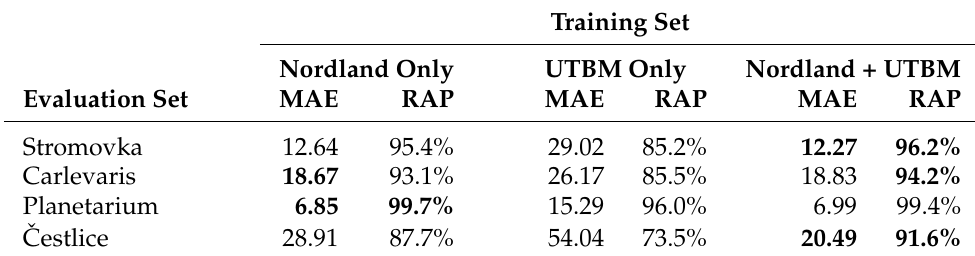
Table 3. Results when trained on different datasets, with both mean average error (MAE) in pixels and ratio of accurate predictions (RAP) calculated as described in Section 4.4. The threshold for ratio of accurate prediction (RAP) was set to 32 pixels, which corresponds to two bins in the outputted representation. Best results are indicated in